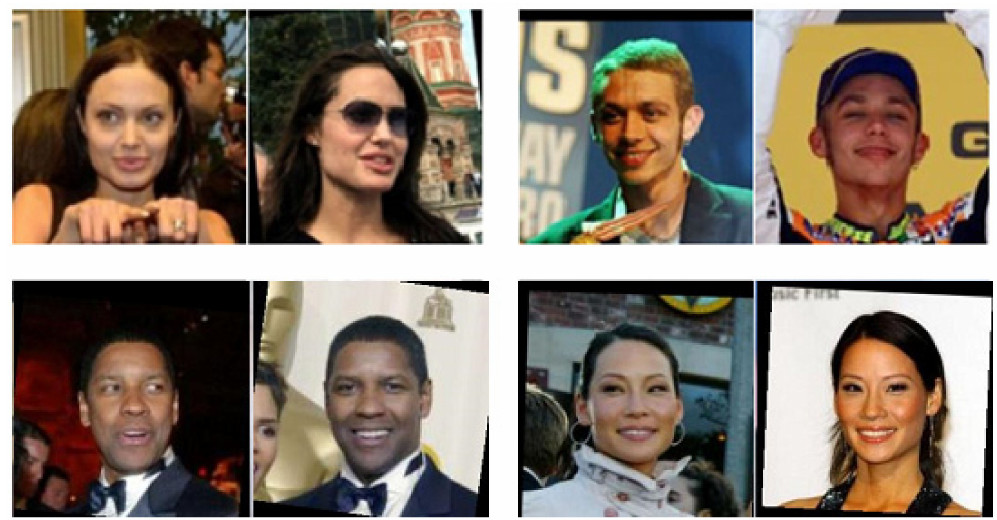
Figure 1. Example images of individuals from the Labelled Faces in the Wild (LFW) Image Dataset (http://vis-www.cs. umass.edu/lfw/, accessed on 23 June